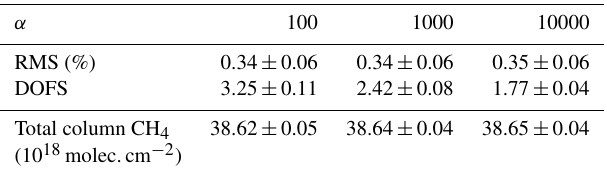
Table 4. The mean and standard deviation of RMS, DOFS and re- trieved CH 4 total columns from SFIT4NIR retrievals using different regularization strength α